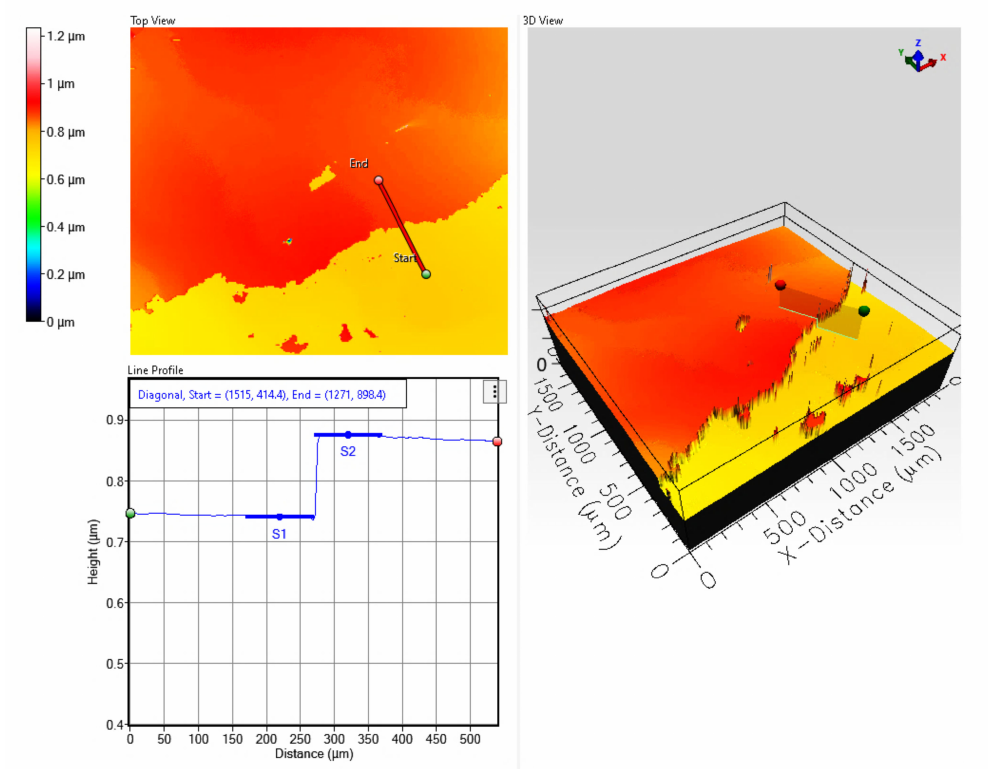
Figure 3. Surface profile and thickness of 50%ZnO50%Ta 2 O 5 film deposited on